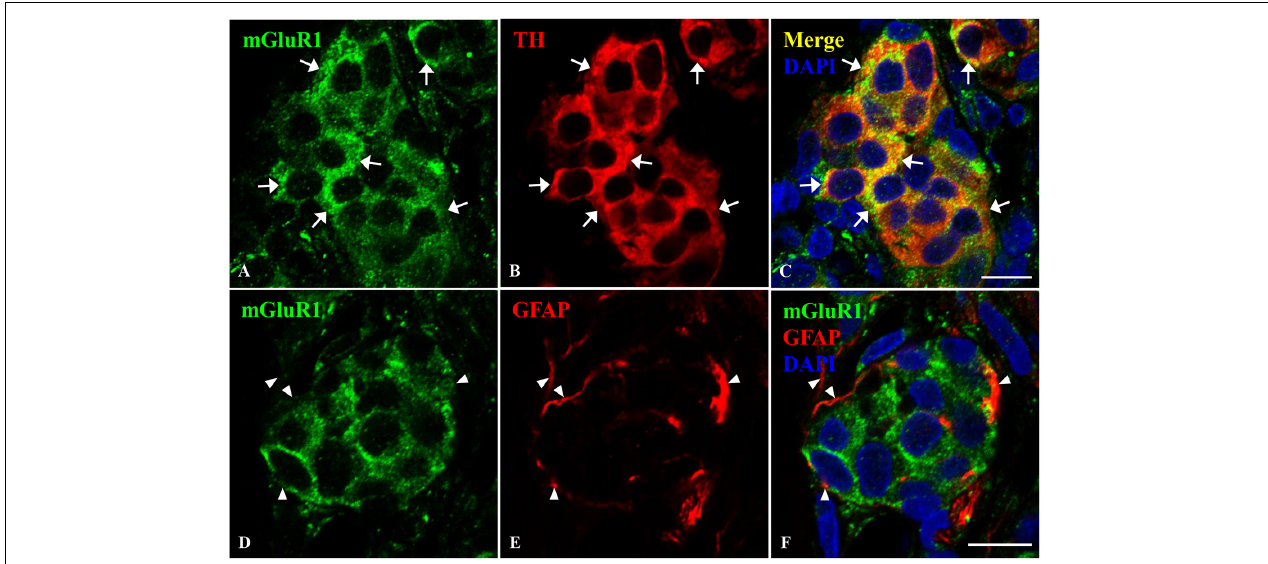
FIGURE 3 | Distribution of mGluR1 in rat CB. Panels (A–C) are double immunofluorescence staining of mGluR1 (green) with TH (red) in rat CB. Panels (D–F) are double immunofluorescence staining of mGluR1 (green) and GFAP (red) in rat CB. Some TH-immunoreactive type I cells are immunoreactive for mGluR1 (arrows), whereas the GFAP-immunoreactive type II cells are not immunoreactive for mGluR1 (arrowheads). TH, tyrosine hydroxylase, the CB type I cells marker; GFAP, glial fibrillary acidic protein, the CB type II cells marker; mGluR, glutamate metabotropic receptor. Scale bar, 10 µ m for all images.